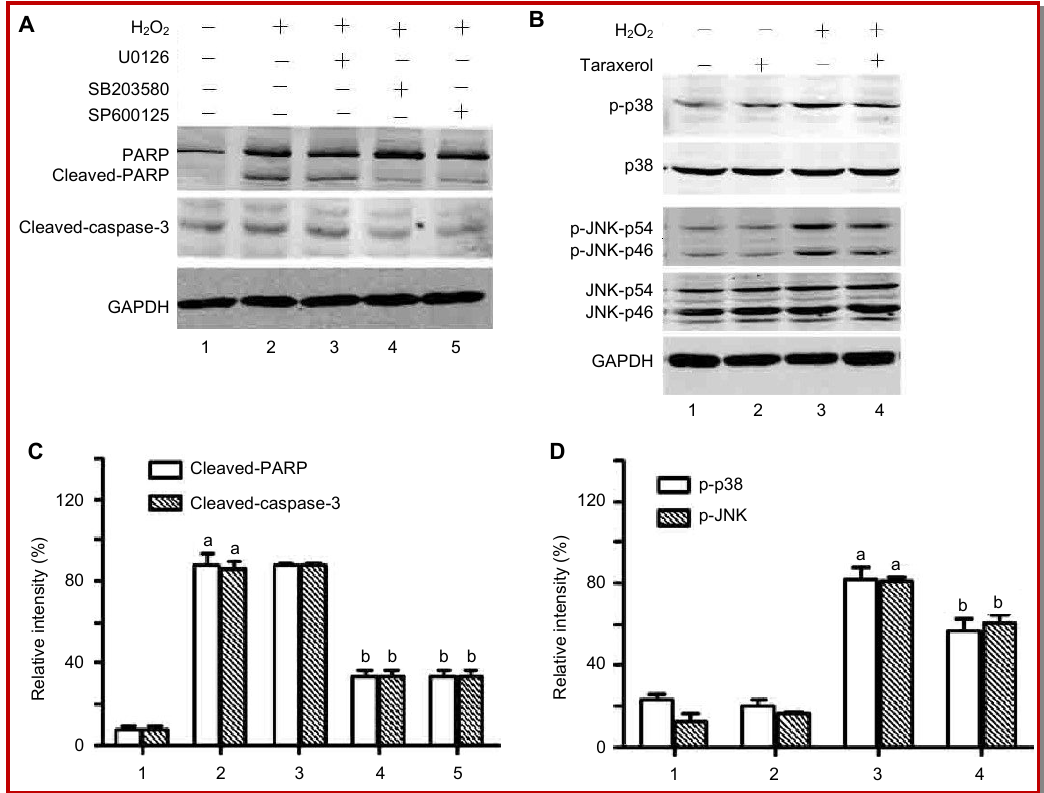
Figure 6: Taraxerol inhibits H 2 O 2 -induced p38 and JNK activation. A) L02 cells were pretreated with 30 μ M U0126, SB203580, or SP600125 for 1 hour, followed by 0.4 mM H 2 O 2 for 12 hours. The cell lysates were detected by antibodies of cleaved-caspase-3, and PARP. GAPDH was used to confirm that equal cell equivalents were loaded. B) L02 cells were pretreated with or without 40 μ M taraxerol for 1 hour and then exposed to 0.4 mM H 2 O 2 for 30 min. The cell lysates were detected by antibodies of p38, phospho- p38 (Thr180/Tyr182), JNK/SAPK, and phospho-JNK/SAPK (Thr183/Tyr185). P38 and JNK were used for normalization. GAPDH was used to confirm that equal cell equivalents were loaded. C) Relative intensity of cleaved-caspase-3 and cleaved-PARP in Fig- ure 6A. D) Relative intensity of phospho-p38 and phospho-JNK/SAPK in Figure 6B. Data are expressed as mean ± SD (n = 3). a p<0.01 compared with control; b p<0.01 compared with the group of H 2 O 2 -treated L02 cells